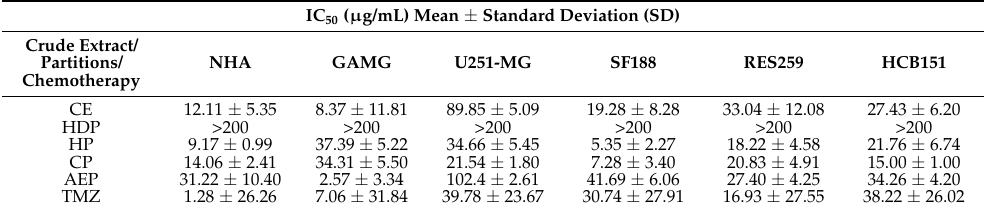
Table 3. IC 50 values for crude extract and partitions from Miconia chamissois and chemotherapy, temozolomide, evaluated at 72